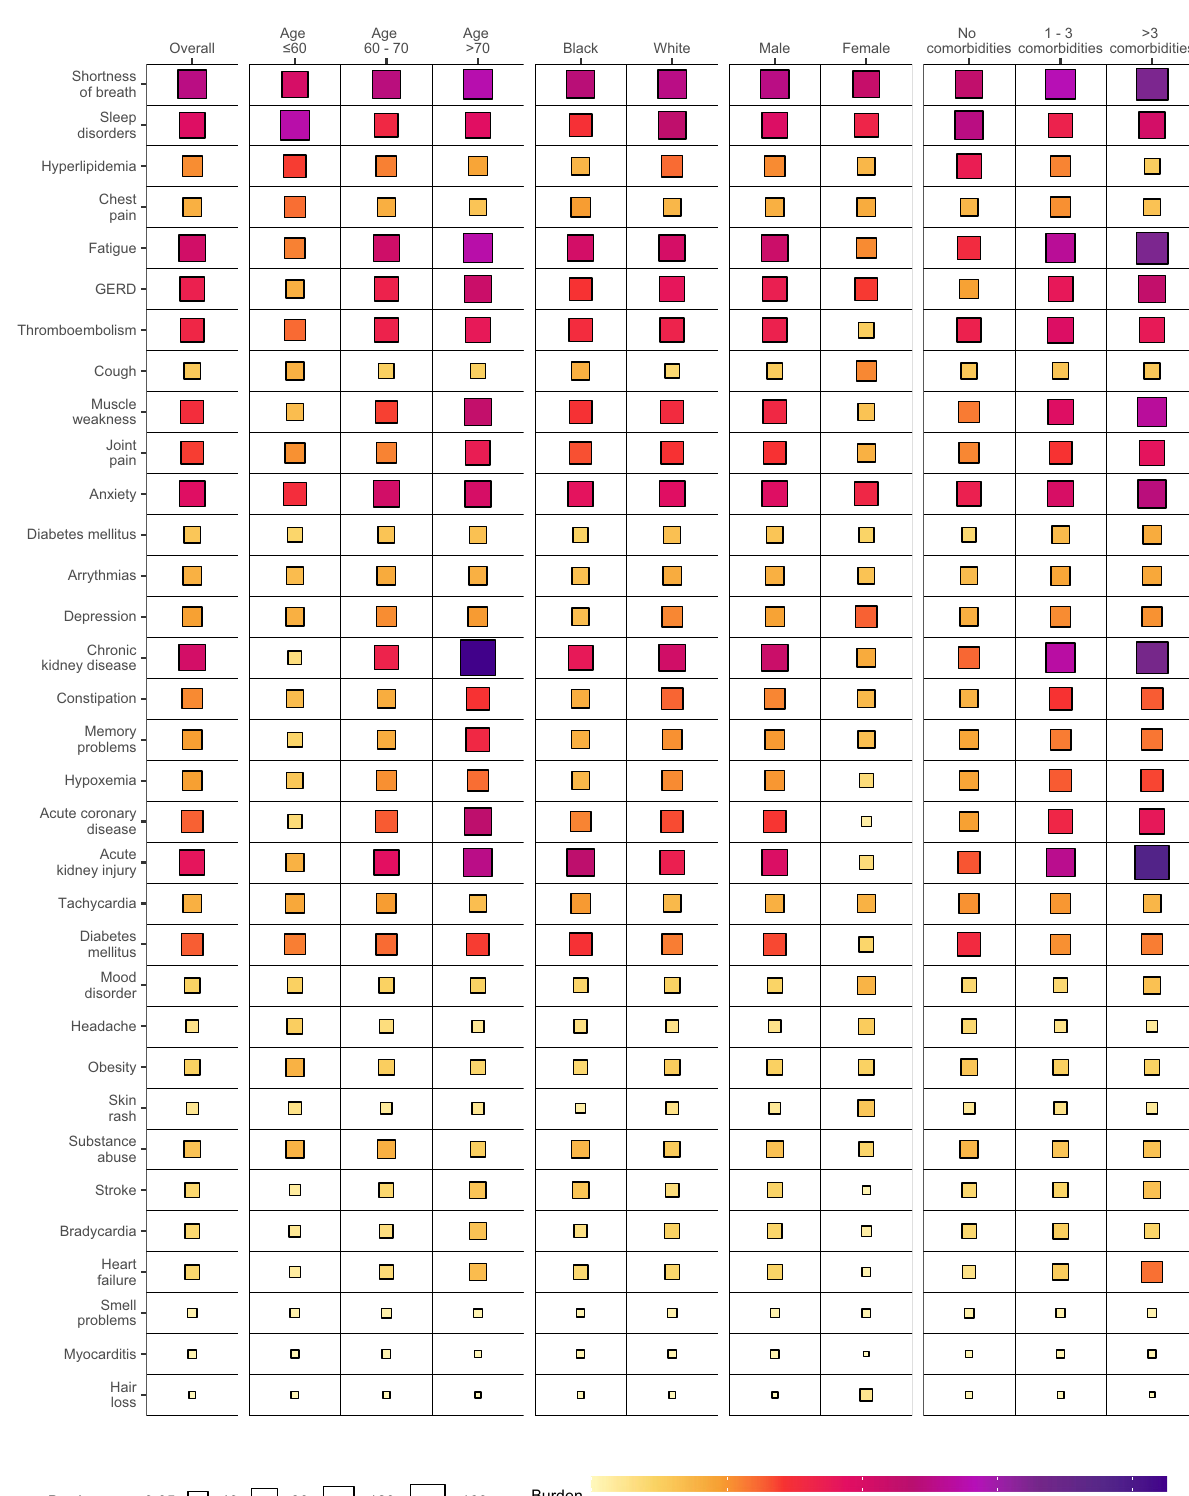
painHyperlipidemiaSleep weaknessCoughThromboembolismGERDFatigueChest painMuscle mellitusAnxietyJoint Diabetes diseaseDepressionArrythmias problemsConstipationChronic kidney diseaseHypoxemiaMemory injuryAcute coronary mellitusTachycardiaAcute kidney disorderDiabetes rashObesityHeadacheMood abuseSkin StrokeSubstance failureBradycardia problemsHeart lossMyocarditisSmell Hair Fig. 7 Burden of post-acute sequelae of COVID-19 in the overall cohort and by age, race, sex, and health status in COVID-19 patients admitted to intensive care. Estimates of burdens per 1000 COVID-19 patients at 6 months are presented. The size of the square represents the burden within each care setting. The intensity of color from light yellow to deep purple represents the range of burdens across care settings. Models adjusted for age, race, sex, receipt of long-term care, Area Deprivation Index, number of outpatient encounters, number of hospital admissions, number of outpatient prescriptions, number of outpatient serum creatinine measurements, chronic lung disease, cancer, cardiovascular disease, cerebrovascular disease, dementia, diabetes mellitus, hypertension, hyperlipidemia, depression, anxiety, chronic kidney disease, hepatitis C and peripheral artery disease, overweight, obesity, smoking status, Charlson Comorbidity Index, US geographic region, total number of beds, number of COVID-19 tests administered, COVID-19 positivity rate, and average hospital bed occupancy during the week of participant enrollment when